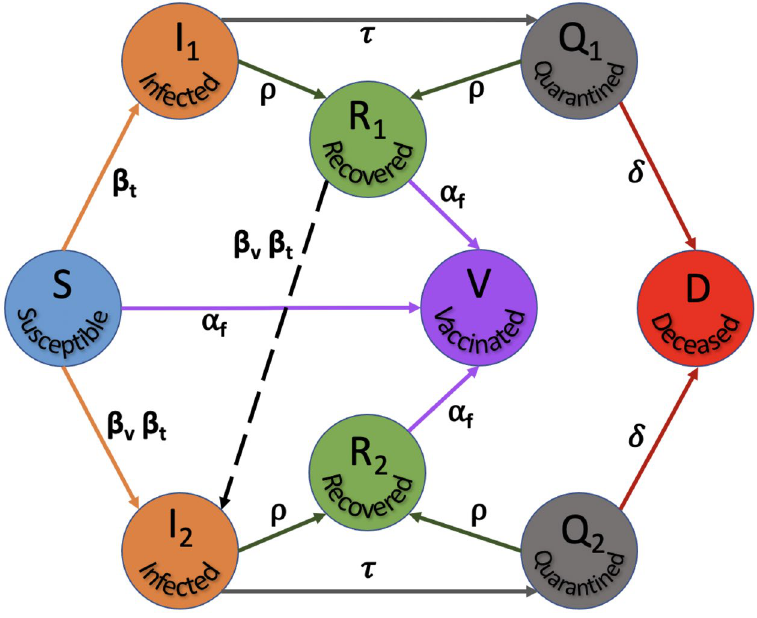
Figure 1. The SI 2 Q 2 R 2 VD dynamics governed by β t , β v , α f , τ , ρ , δ rate